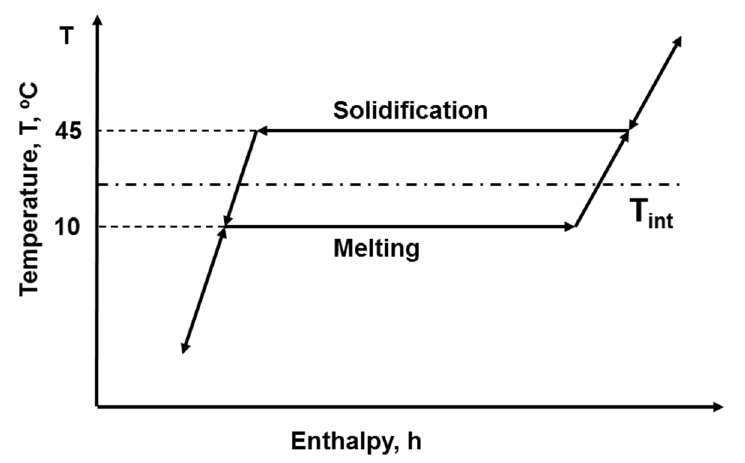
Figure 9. Material with suitable hysteresis for the heating and air conditioning of